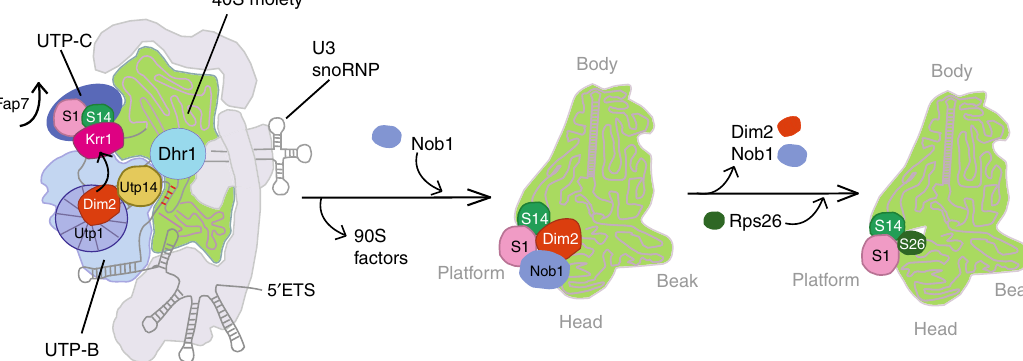
Fig. 6 Model of how Krr1 and Dim2 function during 90S-to-pre-40S subunit transition. Krr1 is depicted at a distinct site on the 90S pre-ribosome, where it binds adjacent to Rps14 and Rps1 and helps to recruit of UTP-C complex (Utp22 and Rrp7). It is possible that Krr1 facilitates early incorporation of Rps14 and Rps1 into the 90S pre-ribosome with the help of Fap7, which dissociates during this step, thereby making the rRNA binding site on Rps14 available. In contrast, Dim2 is recruited to the 90S pre-ribosome by binding to the UTP-B subunit Utp1, depicted as β -propeller protein. The correct positioning of Dim2 at this site allows the subsequent activation of Dhr1 by its activator Utp14. The stimulation of Dhr1 ’ s helicase activity leads to progression in ribosome biogenesis by removal of the U3 snoRNA, a requirement for pseudoknot formation, A 2 cleavage, and the dismantling of the 90S pre-ribosome. Subsequently, the pre-40S moiety is set free with Dim2 undergoing relocation to overtake the previously occupied binding site of Krr1 at the platform/head region of the pre-40S ribosome, with contact to Rps14-Rps1. The positioning of Dim2 in this area allows recruitment of the endonuclease Nob1 at a close-by position. After dissociation of Dim2 and D-site cleavage by Nob1, Rps26 can join the 40S